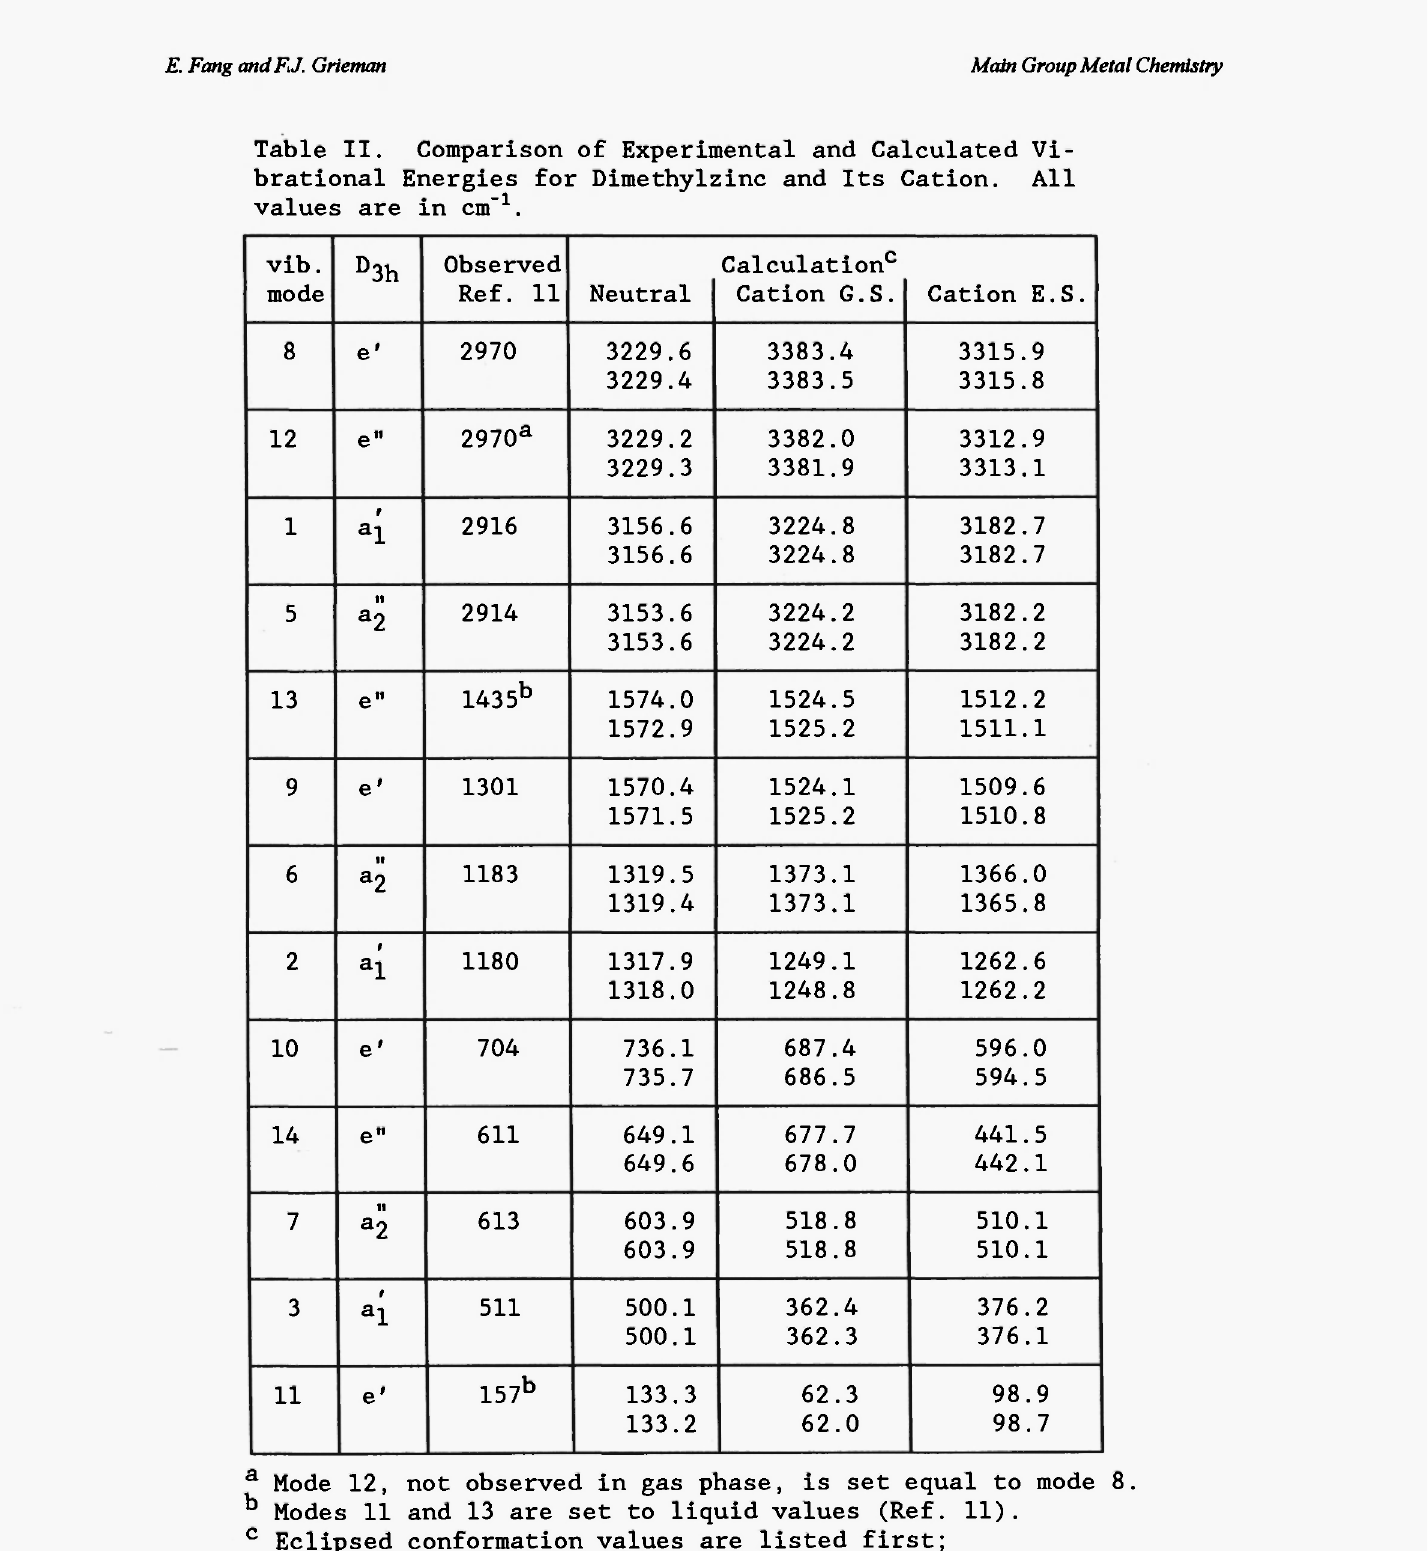
Table II. Comparison of Experimental and Calculated Vi- brational Energies for Dimethylzinc and Its Cation. All values are in cm" 1